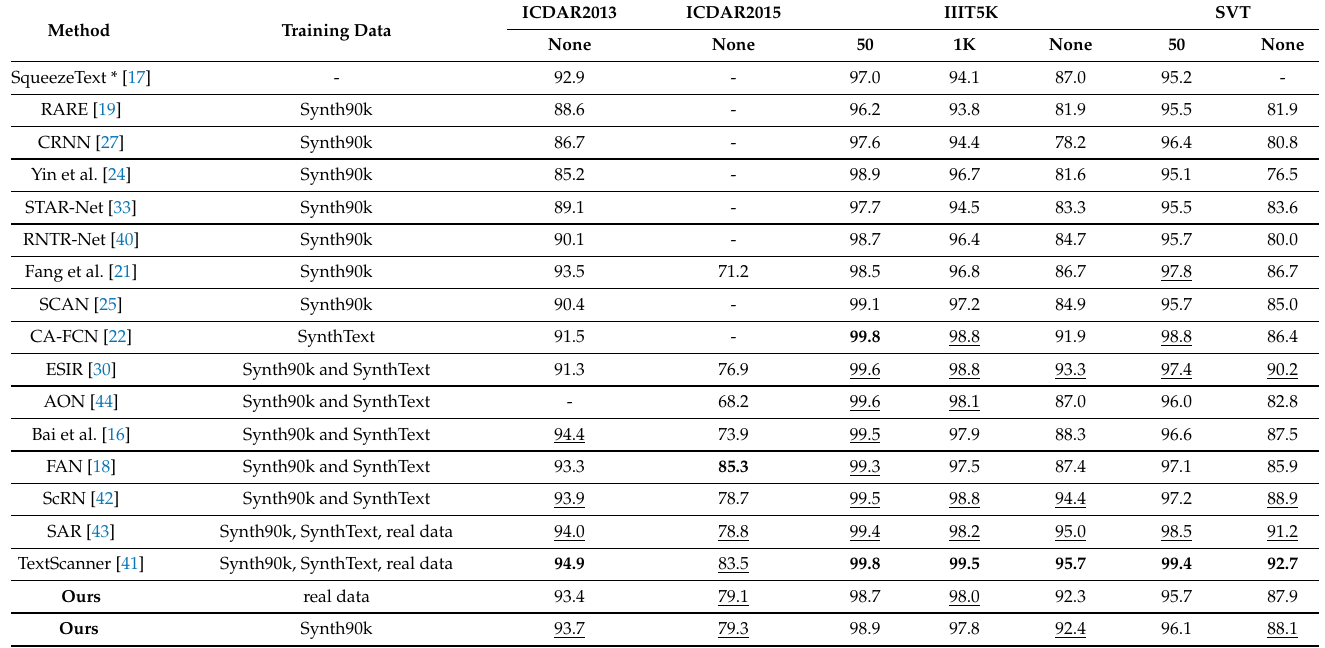
Table 2. The evaluation of the proposed text recognition method and results reported by other methods for comparison. Multiple columns corresponding to the dataset represent evaluation with different lexicons; the lexicon size is mentioned in the next row. The SynthText dataset [45] consists of 8K natural images with 8 million synthetic word instances, placed using different settings. Each text instance is annotated with a corresponding word label, and ground-truth character and word-bounding